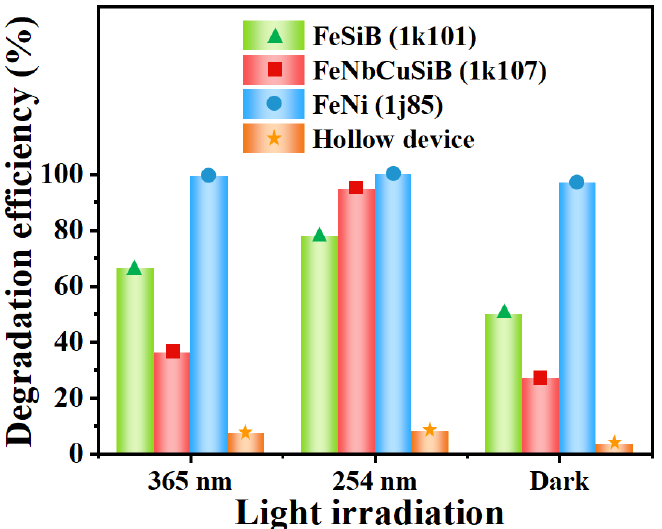
Figure 7. The degradation efficiency of MB by using the microreactors with and without Fe-based sheets under different light irradiation.